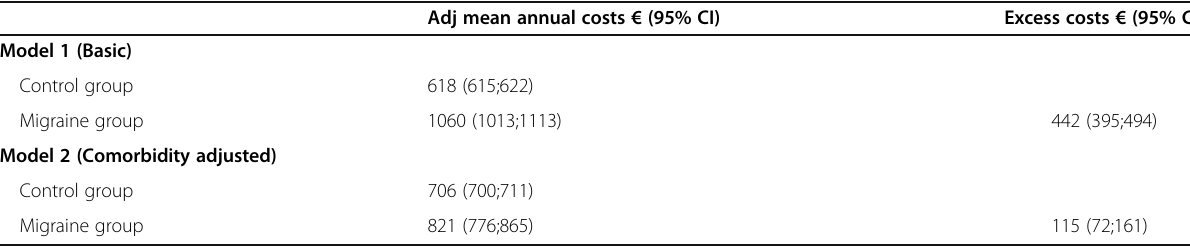
Table 4 Adjusted mean annual costs in the control group and the migraine group, and excess costs of migraine with Bootstrap 95% confidence interval (CI). Model 1 adjusted for age and sex only, model 2 additionally adjusted for